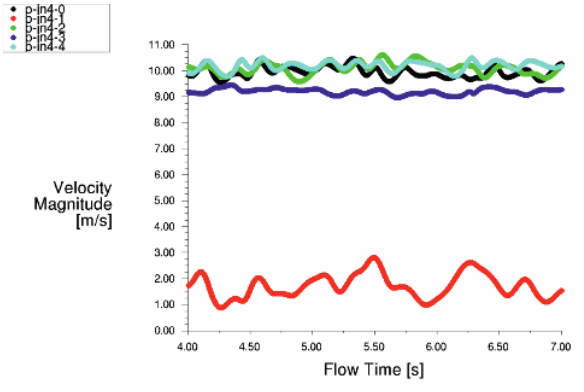
Figure 7: Velocity behavior at the inlet main